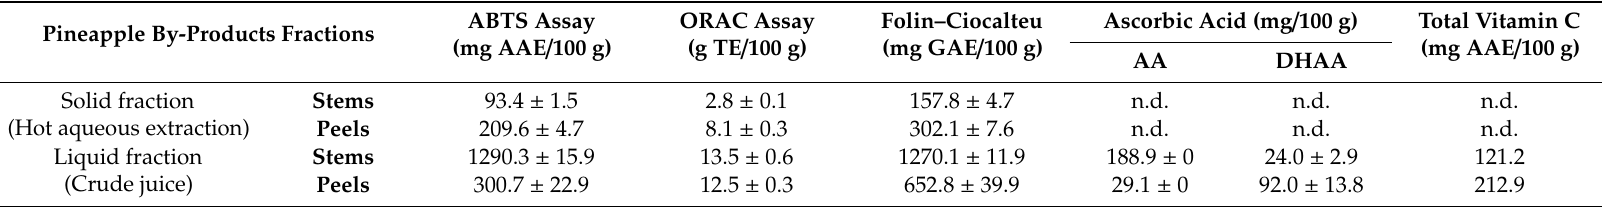
Table 4. Evaluation of antioxidant capacity (ABTS and ORAC assay), total phenolic compounds (Folin–Ciocalteu method), and total vitamin C (HPLC method) of pineapple by-products crude liquid fraction (stems and peels). All results expressed in mg / 100 g on a dry basis. Pineapple By-Products